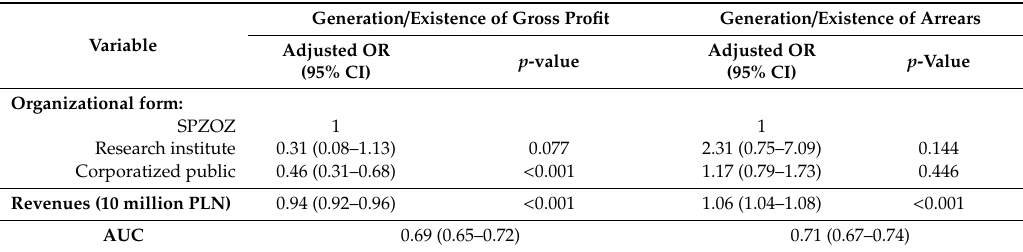
Table 6. Multivariable logistic regression models predicting gross profit and arrears generation (organizational form and revenues as